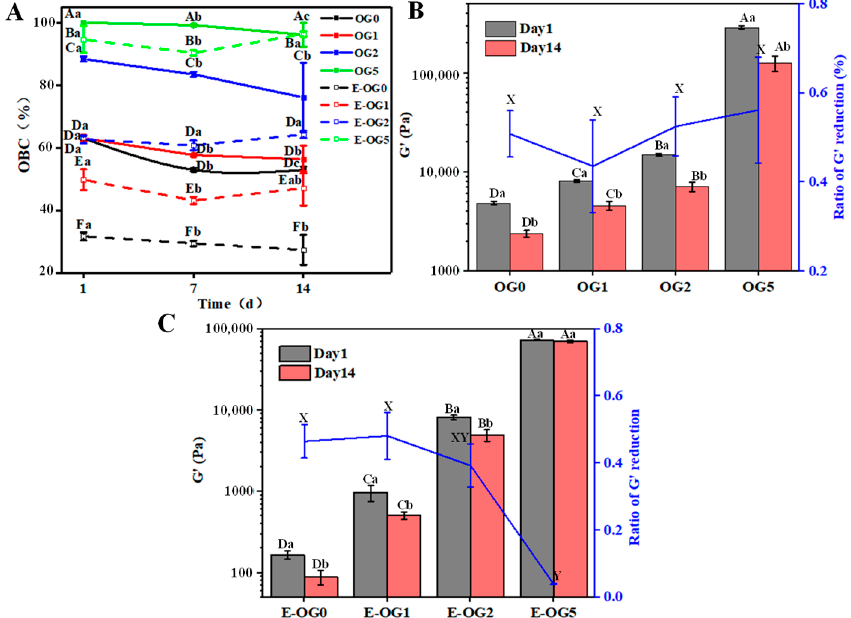
Figure 9. Oil binding capacity ( A ) of oleogels and emulsions. The G (cid:48) value and G (cid:48) reduction ratio of oleogels ( B ) and emulsions ( C ) was evaluated at 1 Hz of frequency sweep. Different uppercase and lowercase letters represent significant differences in different GMS content and storage time, respectively ( p <